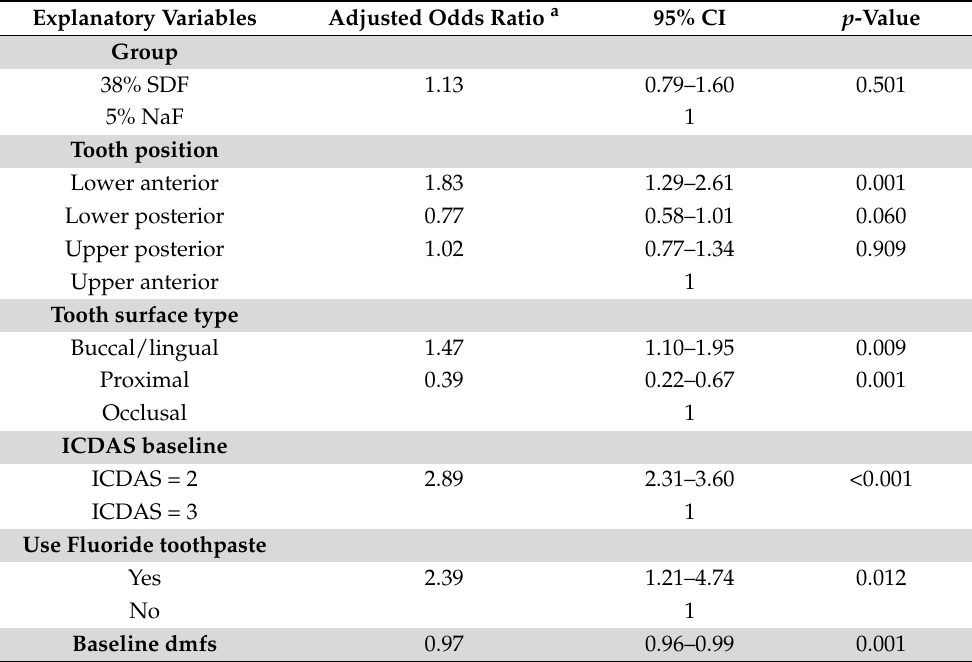
Table 3. Final logistic regression model of the caries arrest rate at the 18-month follow-up with the clustering effect adjusted.